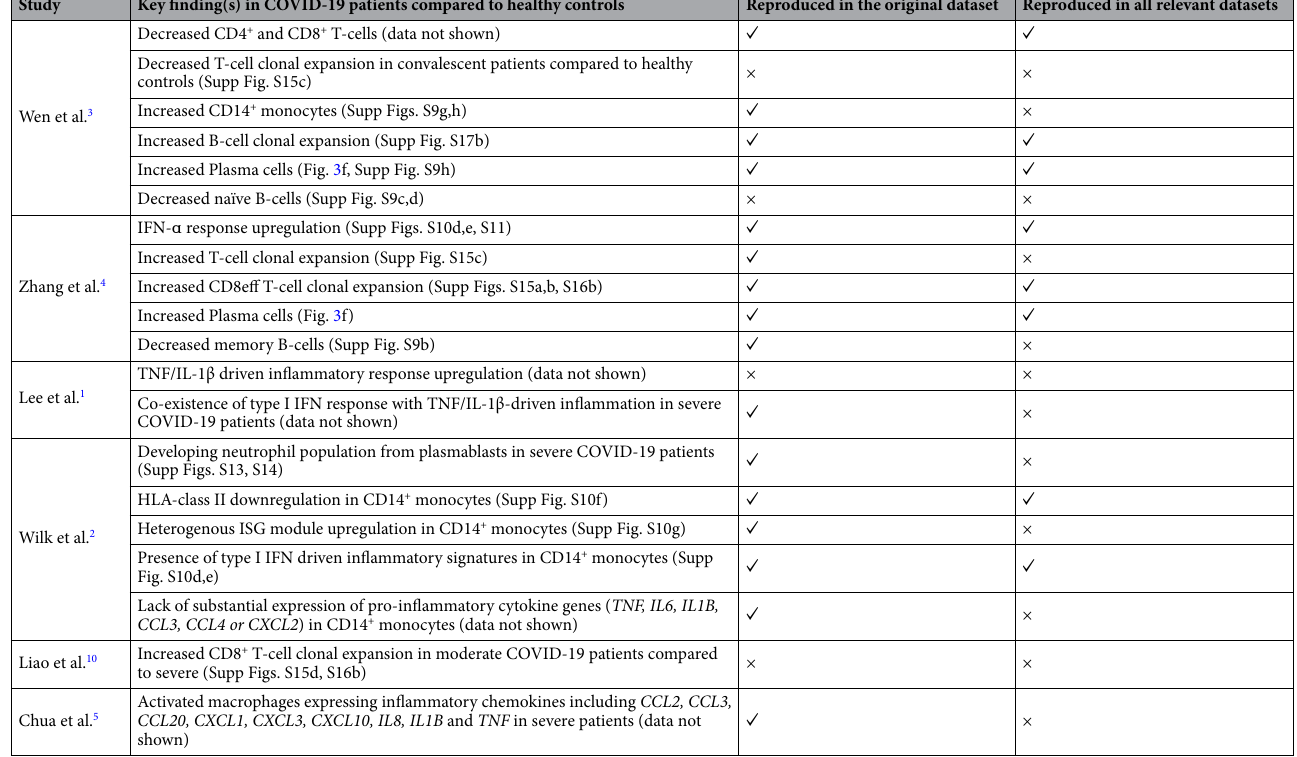
Table 2. Summary of reproducible results across multiple single-cell COVID-19 studies analyzed in this meta-